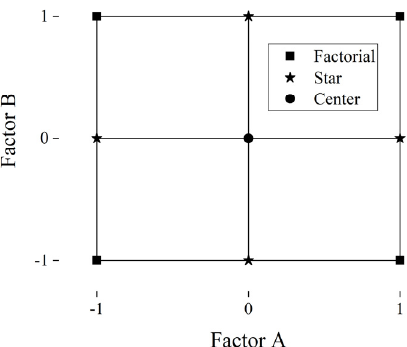
Figure 12. Design points indicated by a